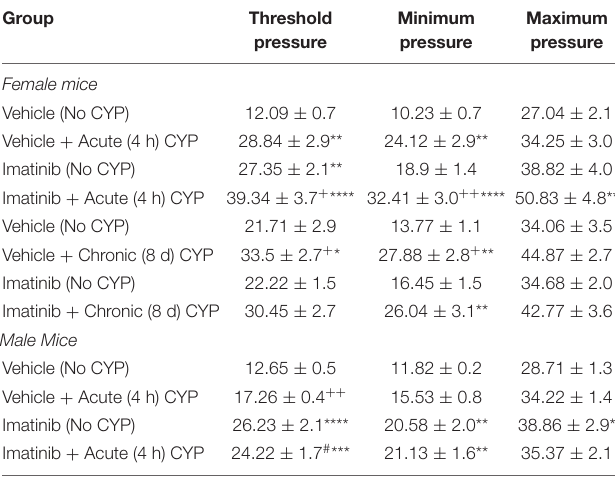
TABLE 1 | Mean bladder pressures during conscious, open-outlet cystometry in control (no CYP), acute CYP (4 h, 200 mg/kg, i.p.), or chronic CYP (75 mg/kg every 72 h for 8 days, i.p.) male and female mice pre-treated with imatinib mesylate or vehicle via oral